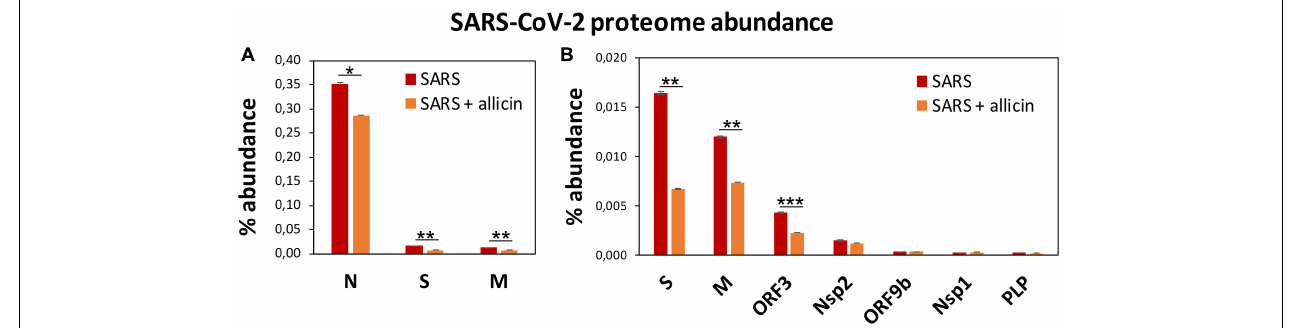
FIGURE 6 | The effect of allicin on the abundance of SARS-CoV-2 proteins in the proteome of infected Calu-3 cells. (A,B) The abundance of the SARS-CoV-2 proteins (N, S, M, ORF3, Nsp2, ORF9b, Nsp1, and PLP) at 24 h p.i. relative to the total proteome abundance of infected Calu-3 cells was calculated in the absence (SARS) or presence of 150 µ M allicin exposure p.i. (SARS + allicin). The N-protein showed a 21–29-fold higher abundance compared to the structural proteins S and M as shown in panel (A) . The lower abundant S, M, ORF3, Nsp2, ORF9b, Nsp1, and PLP proteins are separately displayed in panel (B) . The proteome results were